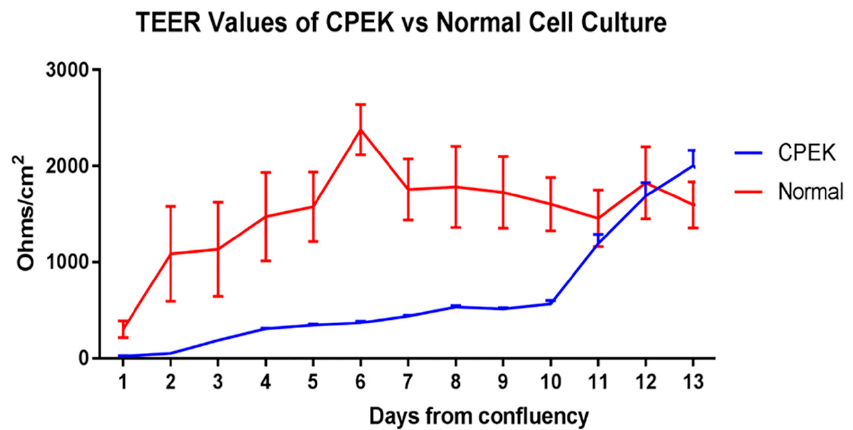
Figure 2. TransEpithelial Electrical Resistance (TEER) of canine progenitor epidermal keratinocyte (CPEK) cells ( n = 3) and normal keratinocytes, NK ( n = 4) in culture over a 13-day period. Graphs shows the mean and Standard Error of the Mean (SEM). Two-way Repeated Measures ANOVA showed a significant effect of time ( p < 0.0001), group ( p = 0.0473) and group x time interaction ( p < 0.0001). Sidak’s multiple comparisons test showed a significant difference between CPEK and normal values on day 6 ( p = 0.0002) and day 7 ( p = 0.0406).